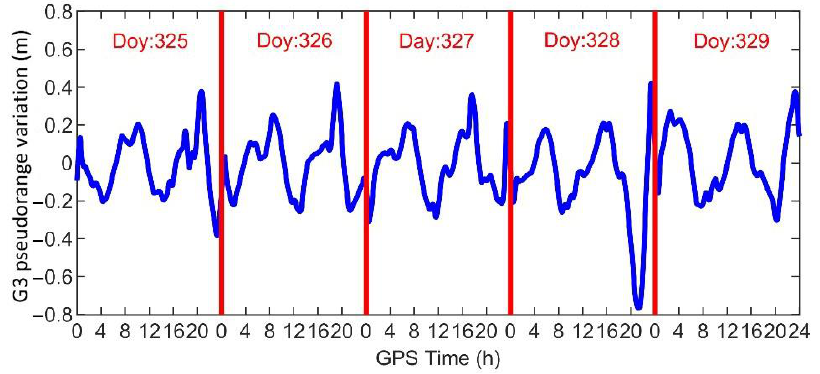
Figure 10. The low-frequency components of the code pseudorange variations of R21 from DOY 325 to DOY 329, 2020. The blue line represents the low-frequency components of the code pseudorange variations using wavelet transformation, and the red vertical line represents the dividing line between two consecutive days.